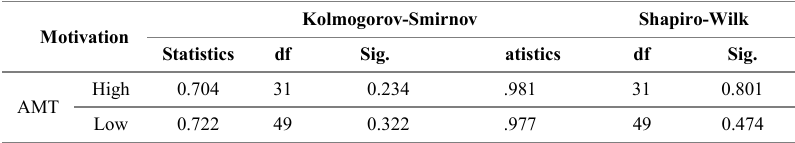
Table 7. Normality Test Results based on Motivation factors.